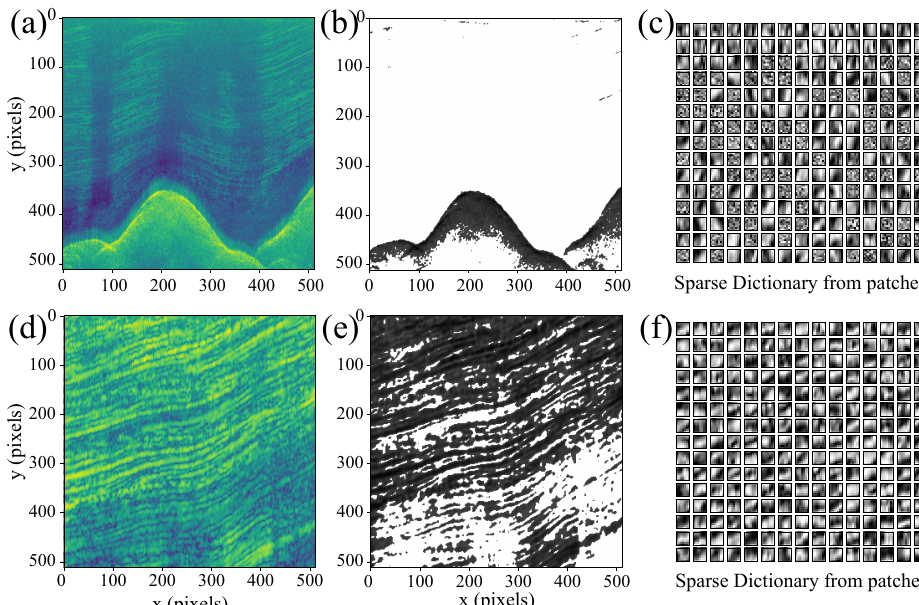
Figure 4. The extracted internal layers from denoised radar images from K-SVD. ( a ) The raw input of the radar image, which contains features of both the bedrock and internal layer and from R3 slices of Line 1; Figure 2. ( b ) The extraction of features by applying a 0.5 threshold in the denoised radar image. ( c ) The sparse dictionary learns from the patches from the input radar image from R1 slices of Line 1; Figure 2. ( d ) The raw input of the radar image, which contains the features of internal layers only. ( e ) Extracted feature by a 0.5 threshold in the denoised radar image from K-SVD. ( f ) The sparse dictionary learns from the patches from the input radar